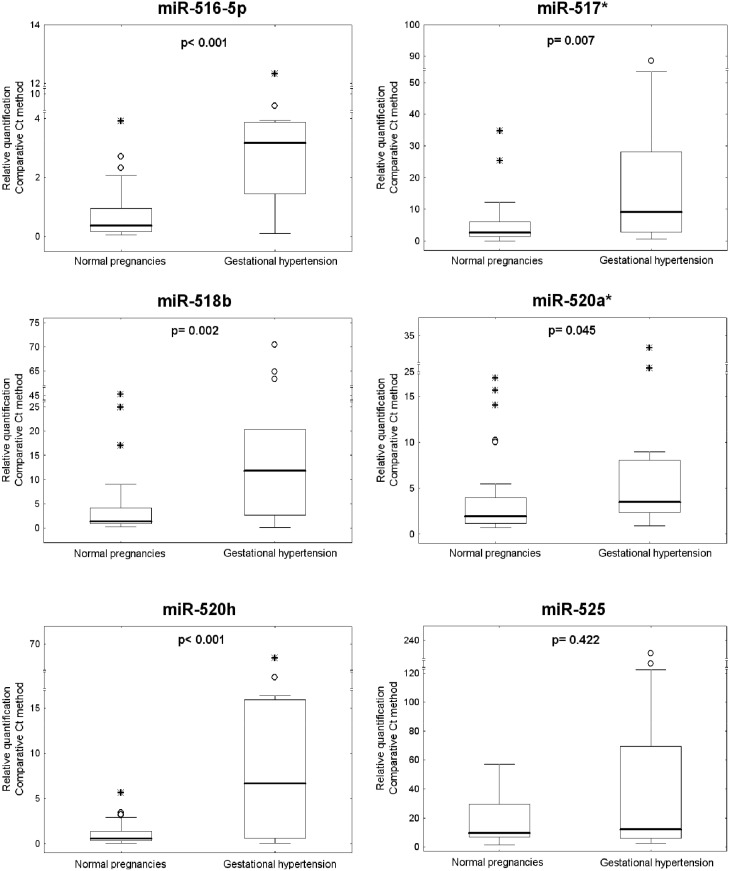
Up-regulation of circulating C19MC microRNAs in pregnancies which developed gestational hypertension.Relative quantification data were expressed as box plots of individual microRNAs in cohorts of normal and complicated pregnancies using Statistica software. The upper and lower limits of the boxes represent the 75th and 25th percentiles, respectively. The upper and lower whiskers represent the maximum and minimum values that are no more than 1.5 times the span of the interquartile range (range of the values between the 25th and the 75th percentiles). The median is indicated by the line in each box. Outliers are indicated by circles and extremes by asterisks.